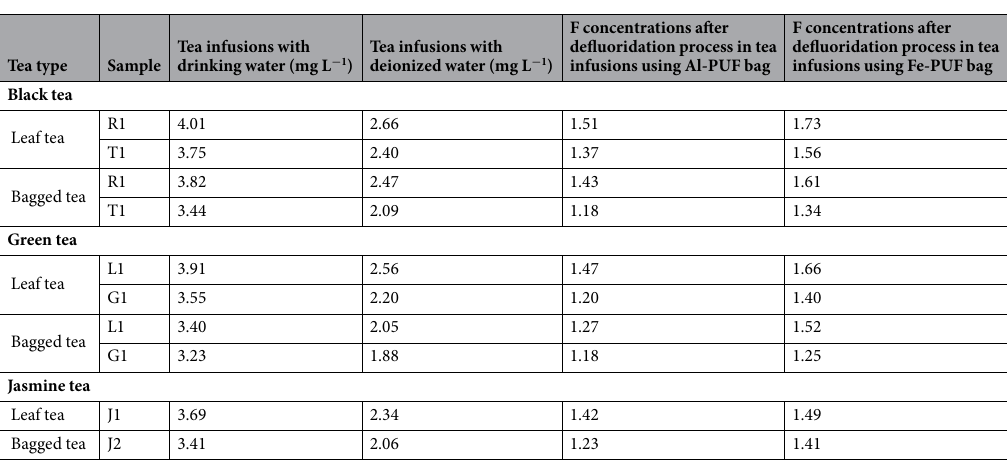
F concentrations after defluoridation process in tea infusions using Fe-PUF bag